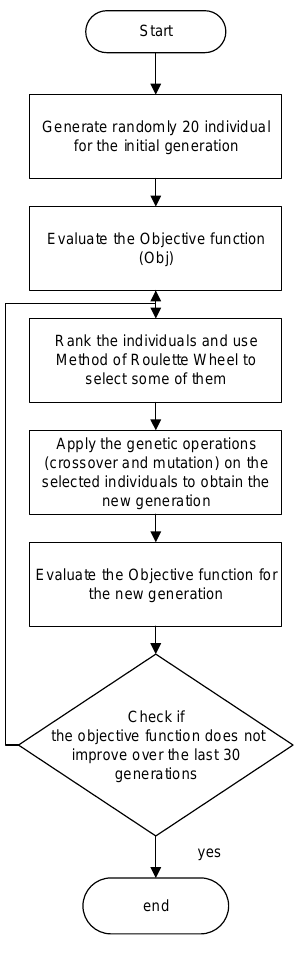
Figure 13. GA algorithm flow chart.